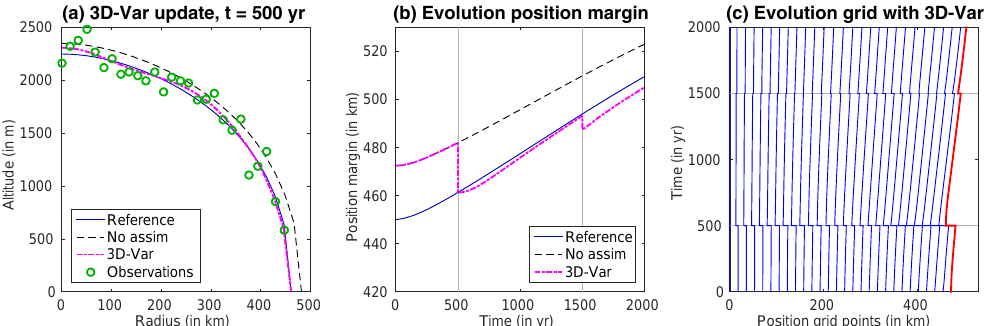
Figure 5. (a) 3D-Var analysis at time t = 500 years compared with the forecast and the reference when we update ice thickness variables and node locations. In contrast to the results shown in Fig. 4, the ice thickness profile is substantially improved close to the margin. (b) Evolution of the position of the margin with time. The estimates are of very good quality even if the margin is not observed directly. (c) Evolution of the position of mesh points with time. The trajectory of each node is corrected by each analysis, as is the margin.